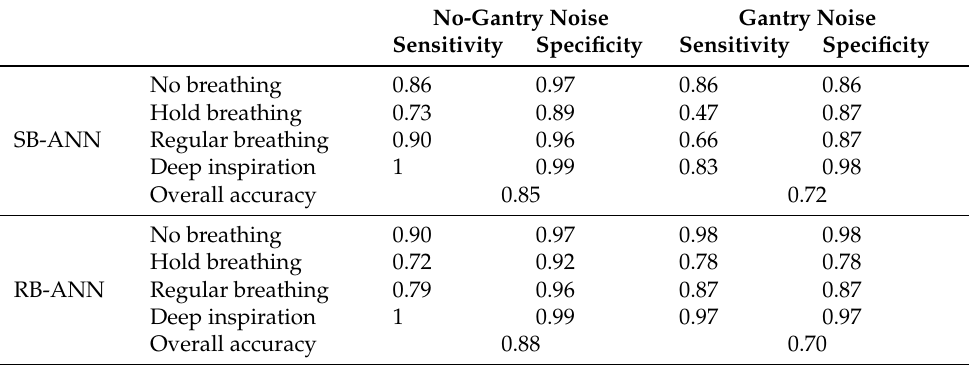
Table 1. Summary of the sensitivity, specificity, and accuracy of the signal processing procedure consisting of ANN noise estimation, range bin weighted averaging and moving average filtering for four different breathing patterns with and without background noise from gantry motion during VMAT treatment